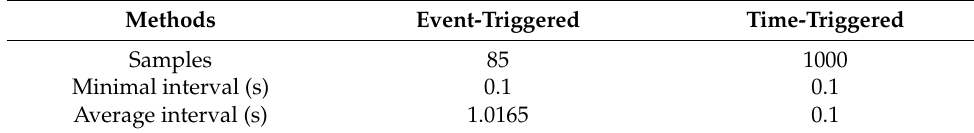
Table 1. State Sampling of Two Strategies.